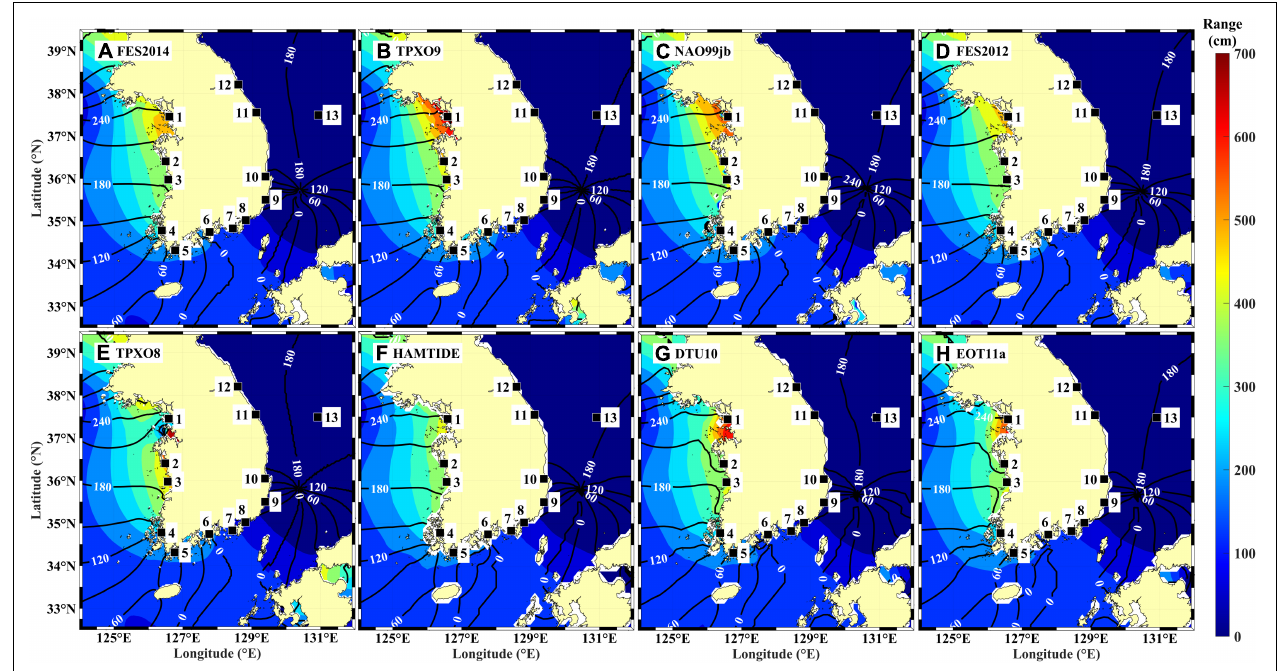
FIGURE 5 | M 2 tidal charts for eight ocean tide models ( A: FES2014, B: TPXO9, C: NAO.99jb, D: FES2012, E: TPXO8, F: HAMTIDE11a, G: DTU10, and H: EOT11a) with co-phase lines (black solid contours; phases in degrees are denoted with white labels) and co-range lines (colors correspond to scale bar shown at right of figure). Contour intervals for tidal phase (black) and amplitude (colors) are 30 ◦ and 60 cm, respectively. Black squares denote TG